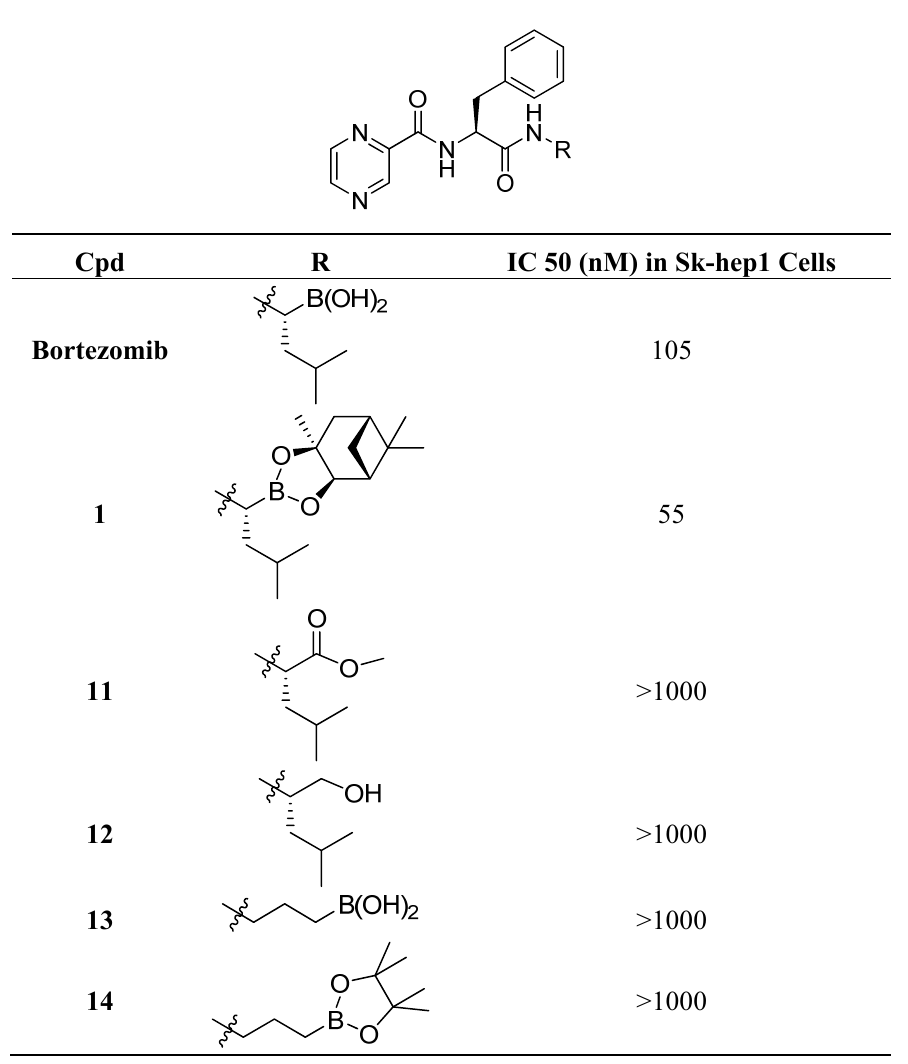
of growth inhibition in Sk-hep-1 cells. 50